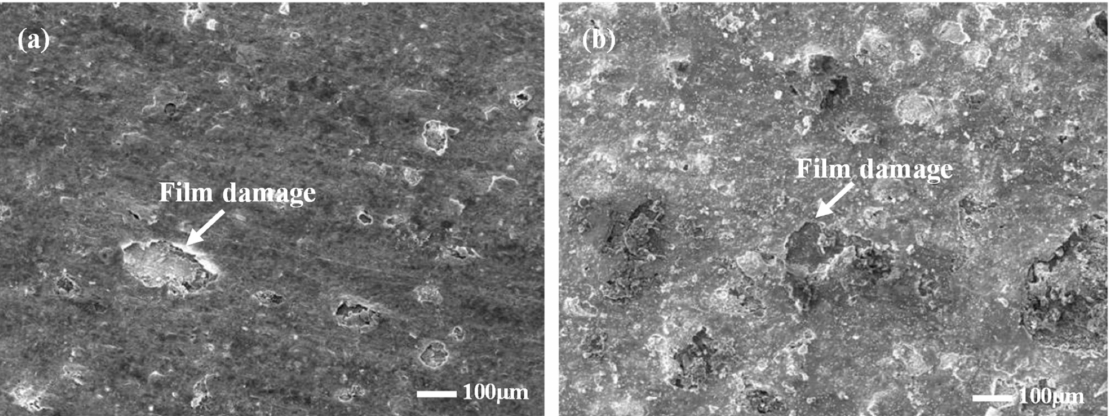
Figure 11. Micromorphology of the inner film of the corrosion inhibitor on the surface of the samples at different test cycles magnified by 100 × (( a ) test cycle 4 h; ( b ) test cycle 12